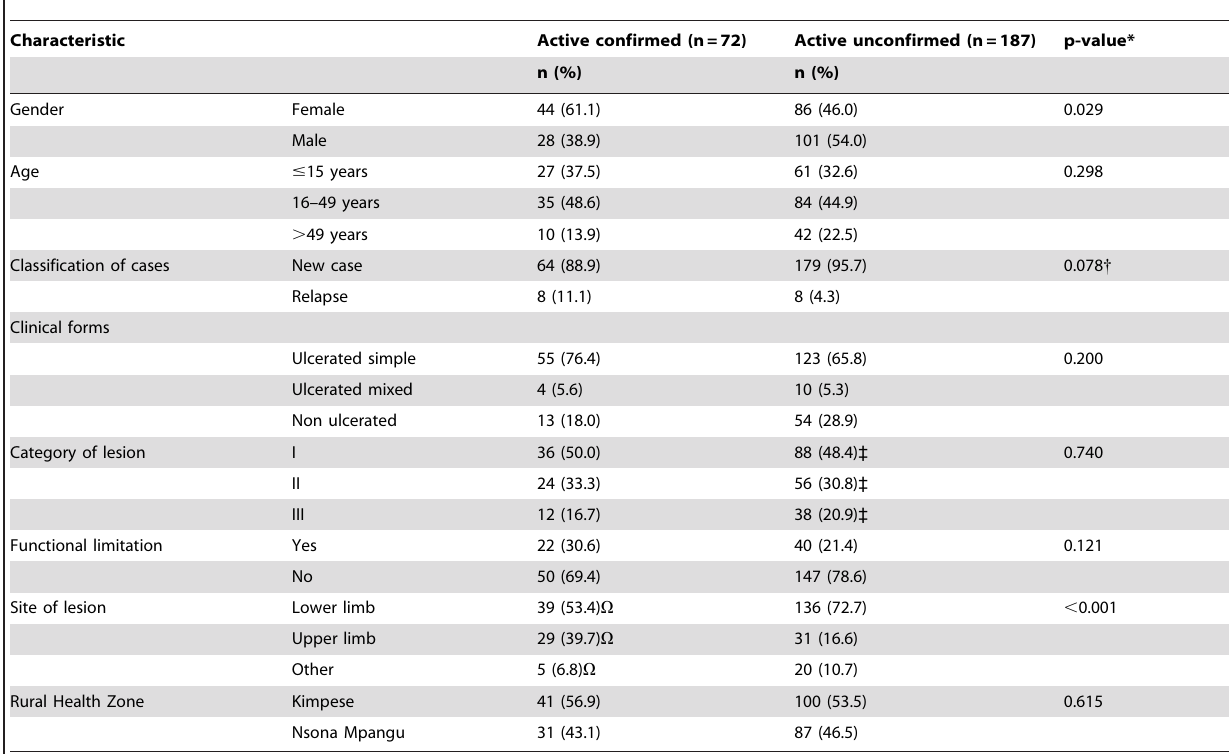
Table 3. Clinico-epidemiological features of active BU cases in the Territory of Songololo, July–August 2008.